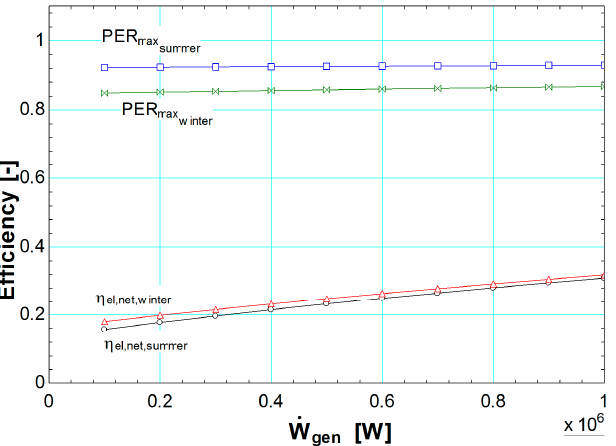
Figure 3. Simulation of the 1 MW e combined cooling, heating, and power system at part ‐ load and full ‐ load: variation of efficiency at full ‐ load and part ‐ load operation.